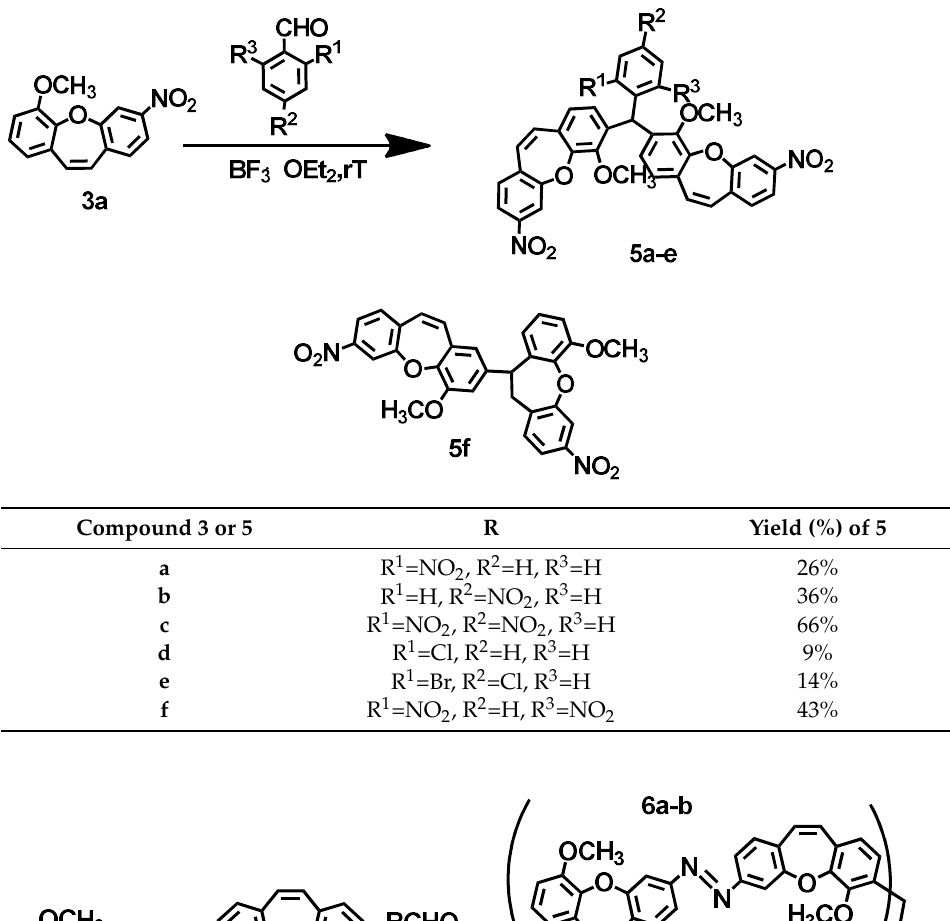
Table 4. Synthesis of ( 5a–5f ) from 3a .